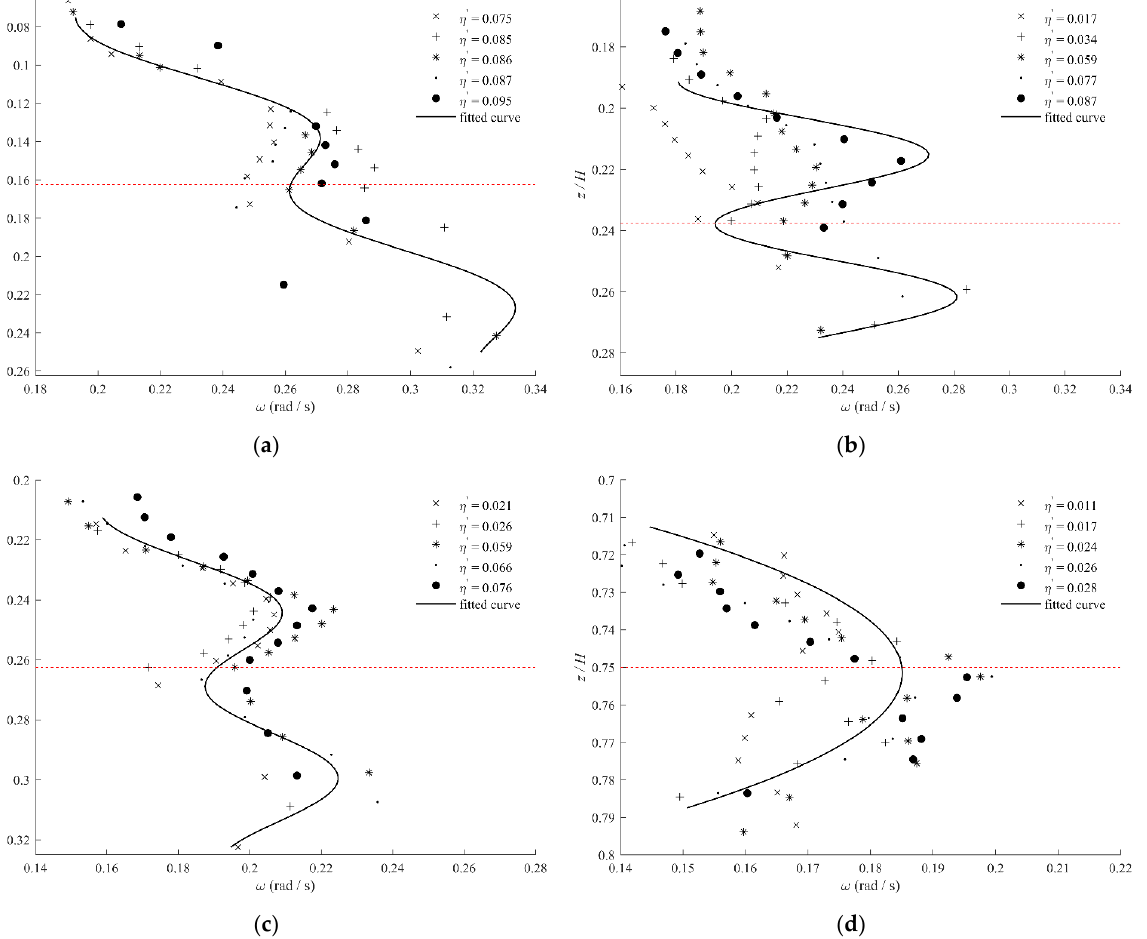
Figure 8. Experimental vertical distributions of the characteristic frequencies: ( a ) S1; ( b ) S2; ( c ) S3; ( d ) S4. The red line represents the depth of the maximum amplitude of ISWs.